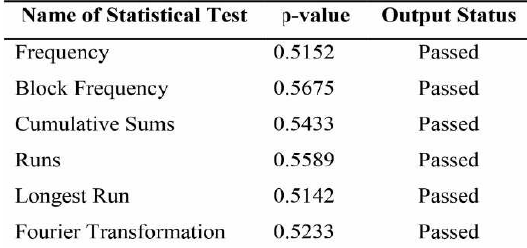
Figure 7. Results of avalanche test.